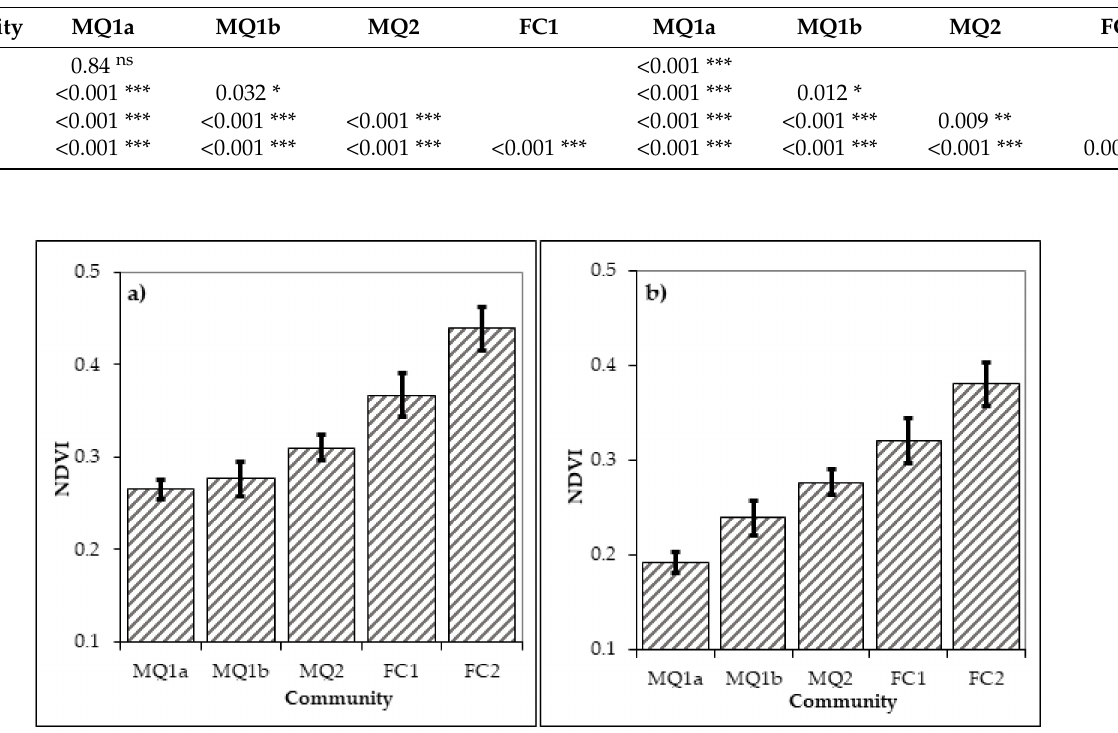
Figure 7. Mean NDVI values and 95% confidence intervals for the different communities in June 1989 ( a ) and August 2001 ( b